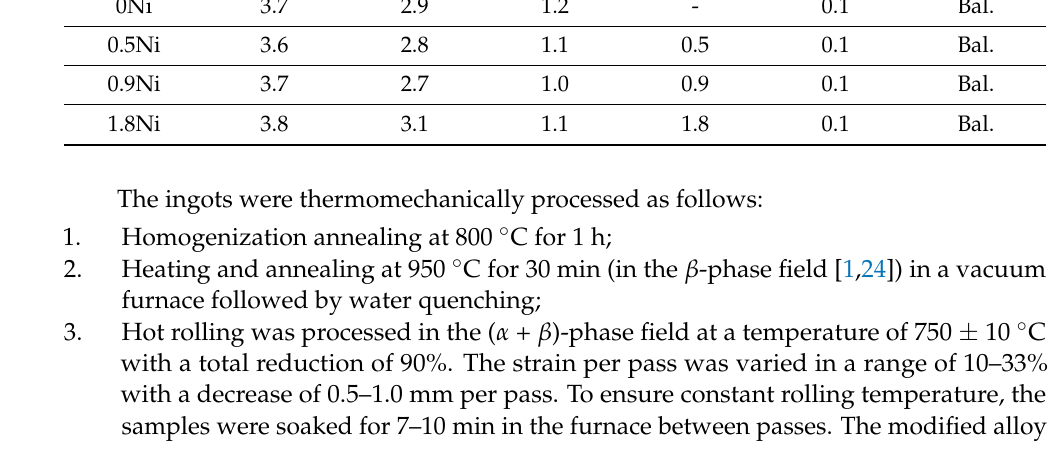
Table 1. Chemical composition of the studied alloys (wt.%).